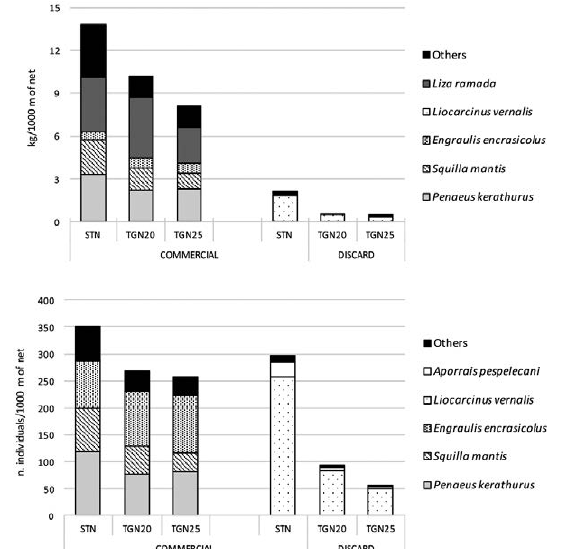
Fig. 3. – Biomass (kg/1000 m of net, above) and density (n. indi- viduals/1000 m of net, below) indices for the most abundant species, according to the type of net and the commercialized and discarded fraction.